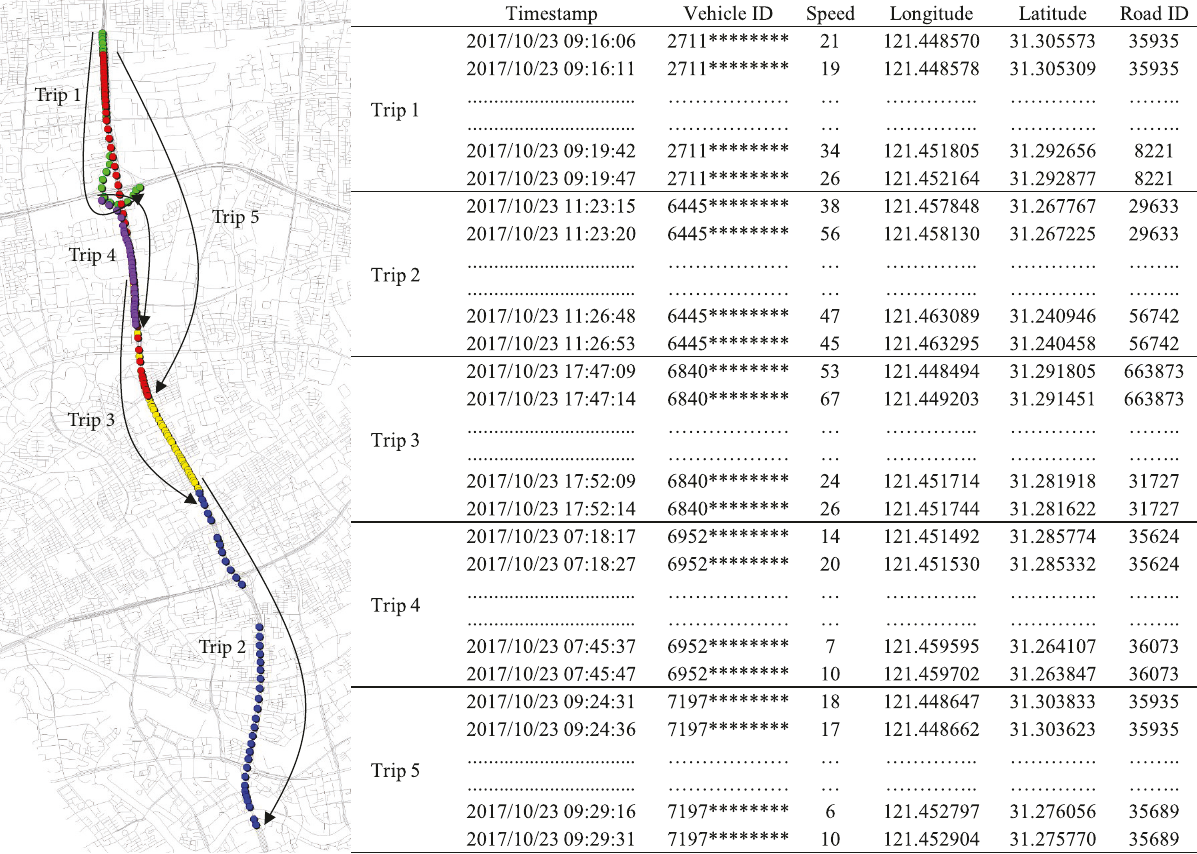
Figure 5: An example of origins and destinations of trips extracted from vehicle trajectory